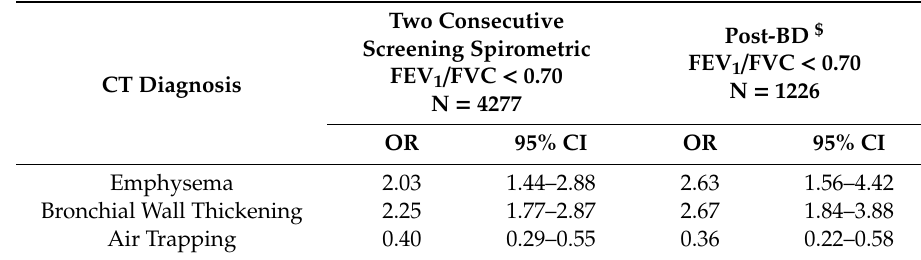
Table 6. Multivariable logistic regression models assessing association of CT diagnosis with two definitions of airflow obstruction*.